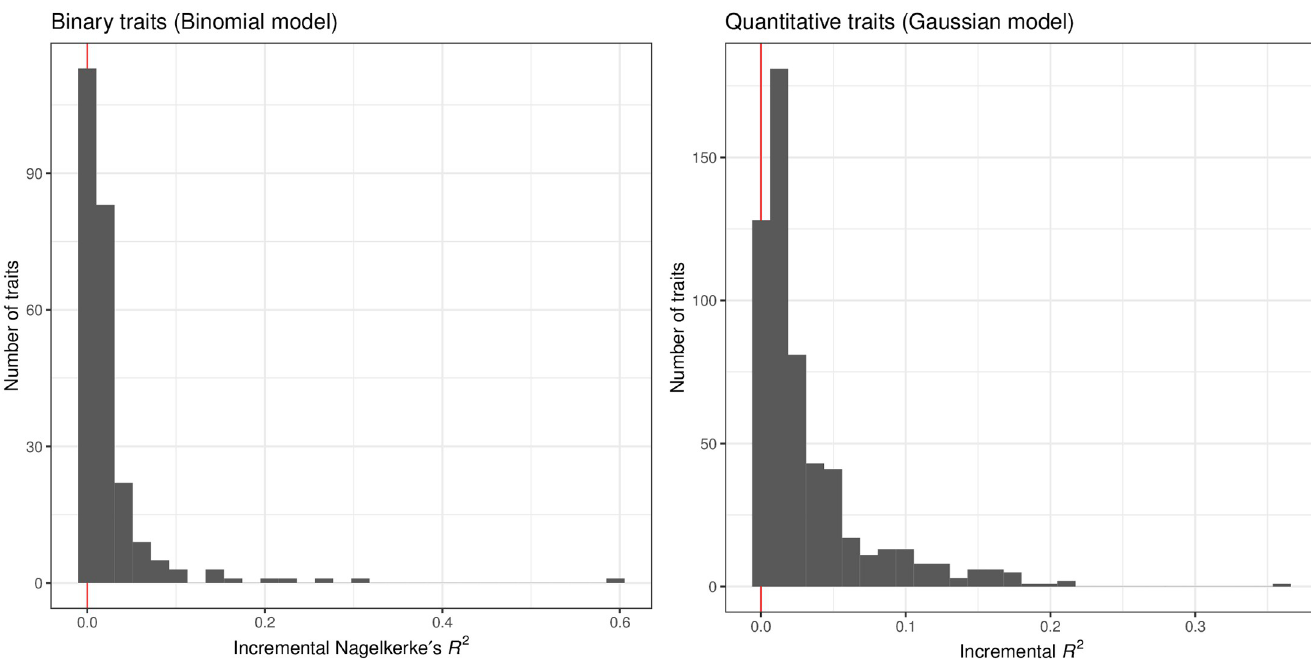
Fig 3. Incremental predictive performance of PRS models across the 813 traits with significant predictive performance in the hold-out test set individuals of white British ancestry. The predictive performance (Nagelkerke’s pseudo- R 2 for 244 binary traits [left] and R 2 for 569 quantitative traits [right]) of the full models that consider both the genotype and covariates are compared against that of the covariate-only models, and their difference (the incremental predictive performance) are shown as a histogram.